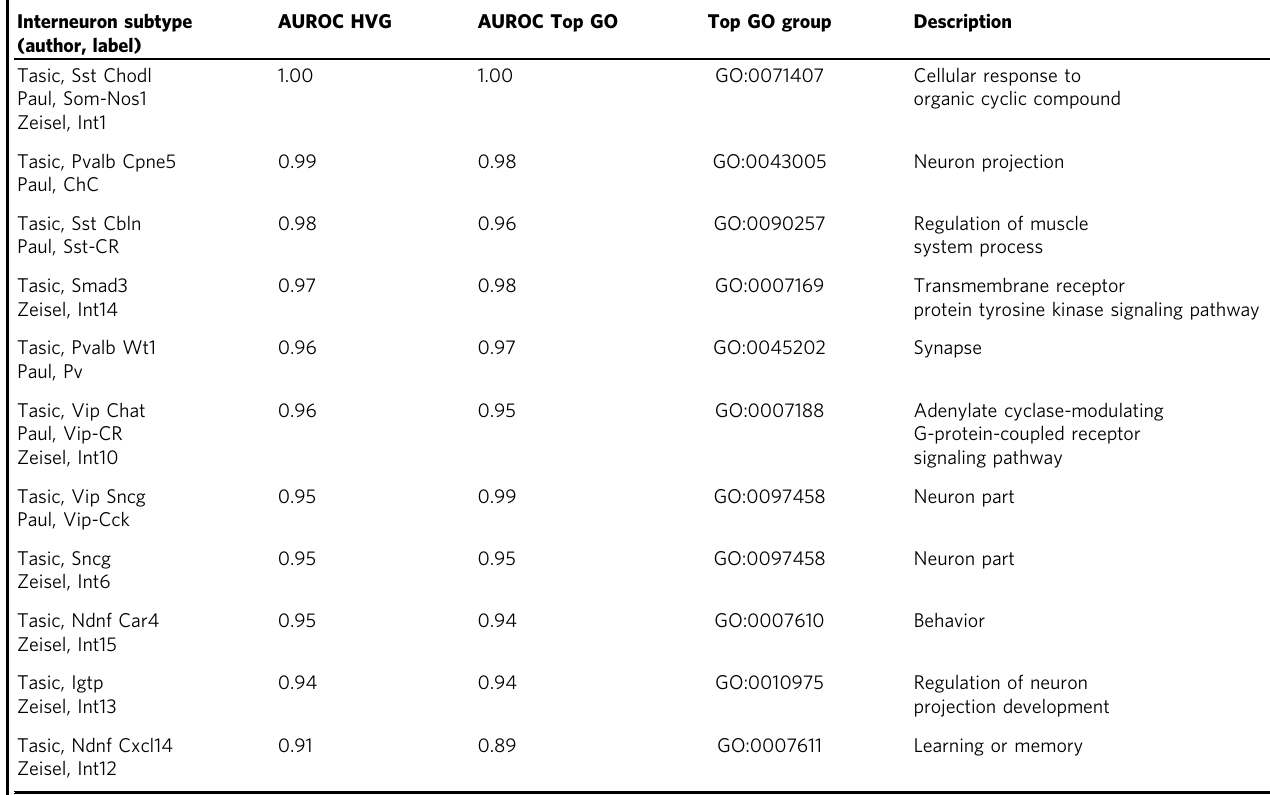
Table 1 Putatively replicated interneuron subtypes and their MetaNeighbor scores for HVG and top GO groups Interneuron subtype (author, label)